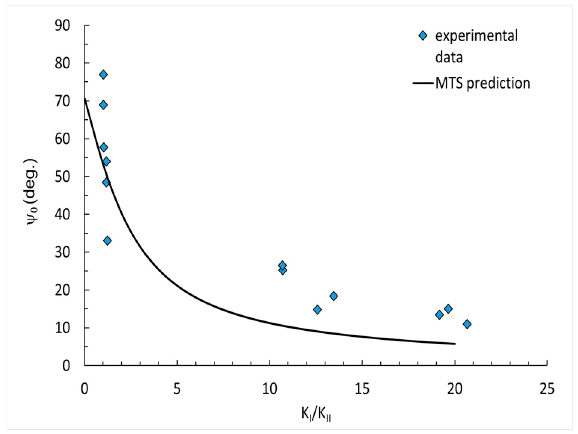
Figure 7. Crack initiation angles for 30phr Al(OH) 3.